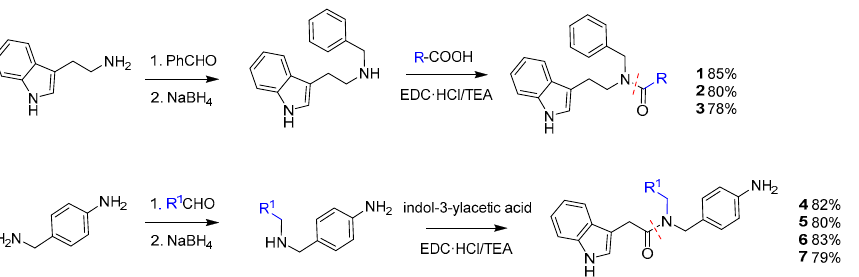
Figure 2. ( A ) Structures of the acyl N -benzyl tryptamine amides 1–3 , prepared according to path A, and ( B ) of the indolyl acetic acid amides 4–7 obtained via path B. The variable groups are rendered in blu.